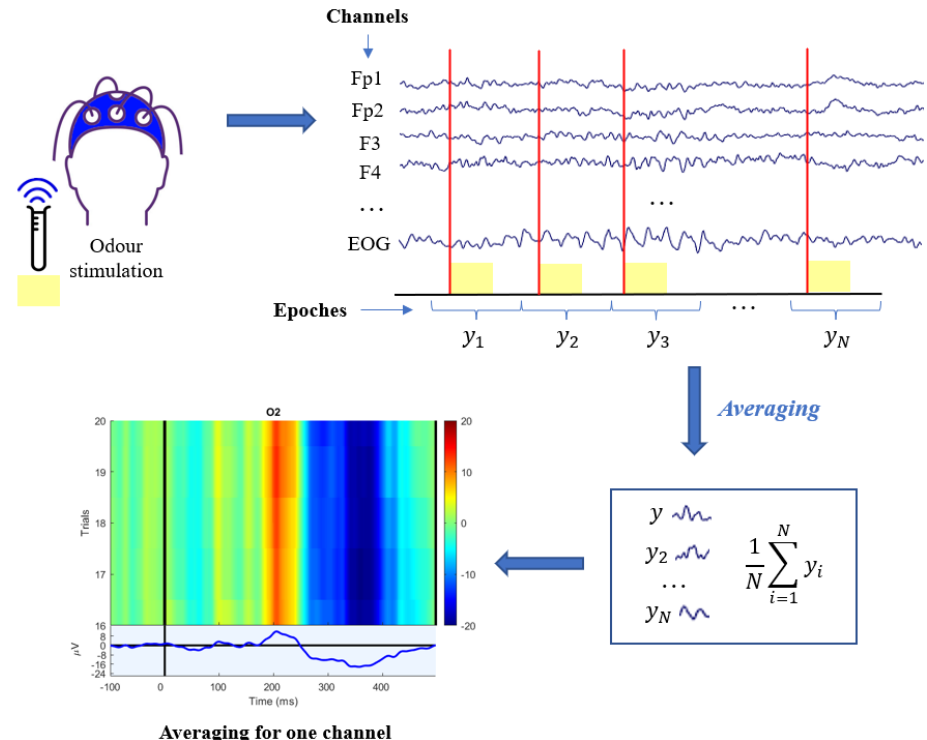
Figure 3. Grand averaging and its construction. In the ERP-image plot, each single trial is encoded as a colored line, warm colors representing positive activity and cool colors, negative